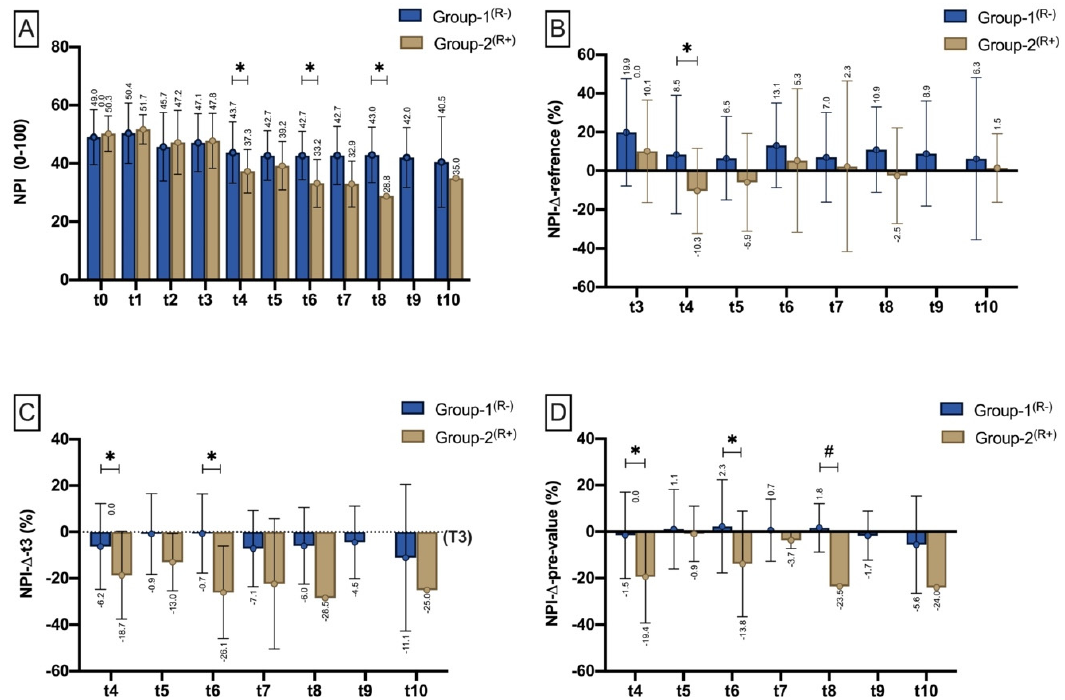
Figure 5. Bar chart with means ( ± SD) show NPI at different measurement timepoints (t0–t3)/time intervals (t4–t10) as ( A ) (NPI mean), ( B ) NPI drop to reference (%) NPI drop to the respective reference site (NPI Δ reference), ( C ) NPI drop to t3 (NPI Δ t3), and ( D ) in relation to the pre-measurement (NPI Δ pre-value). Means are shown scalar. Asterisk (*) marks existing significance. ANOVA (#).